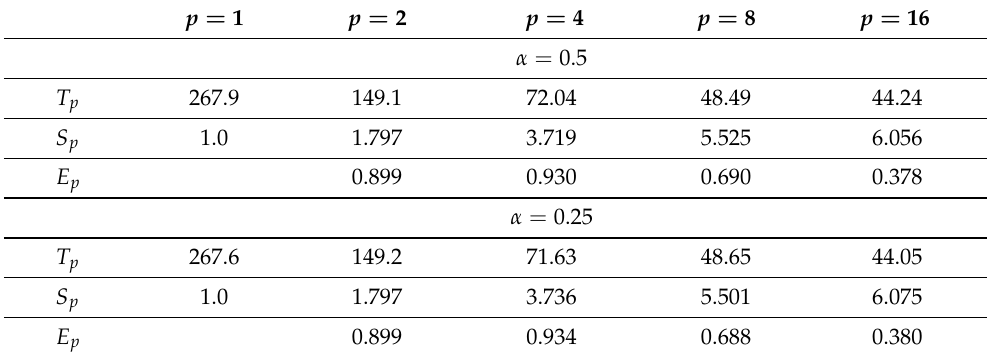
Table 5. The AAA algorithm (19): the values of the speedup S p and efficiency E p numbers for α = 0.5,0.25 and different numbers of cores. The order of AAA algorithm is fixed to m = 10.